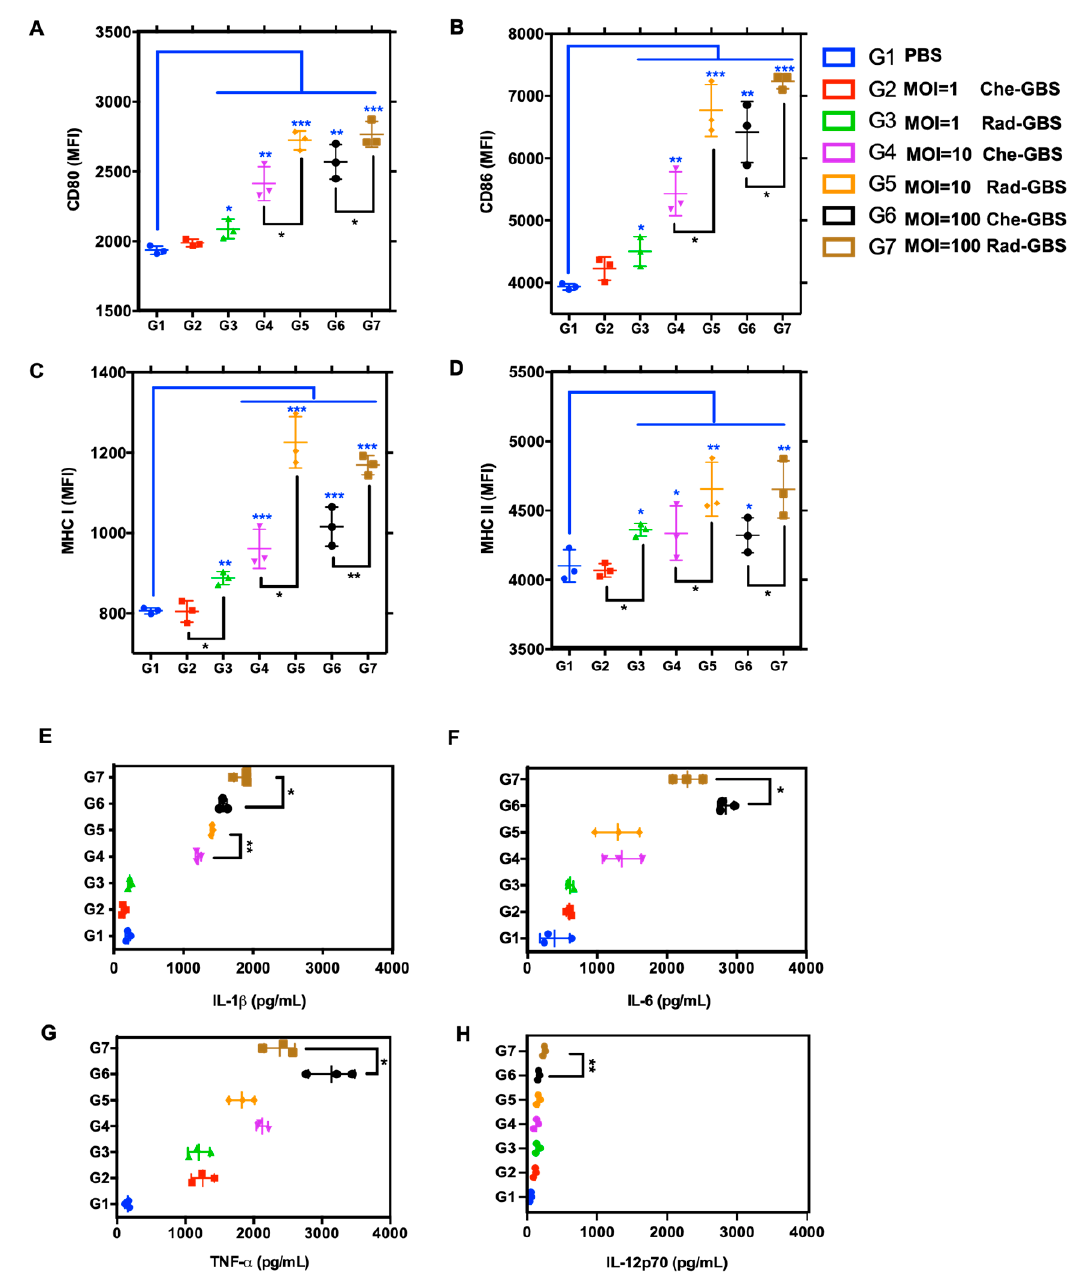
Figure 2. Rad-GBS enhances the activation of BM-DCs in comparison to that with Che-GBS . Bone marrow-dendritic cells (BM-DCs) (2 × 10 6 cells/mL) were isolated and incubated with GM-CSF, fol-